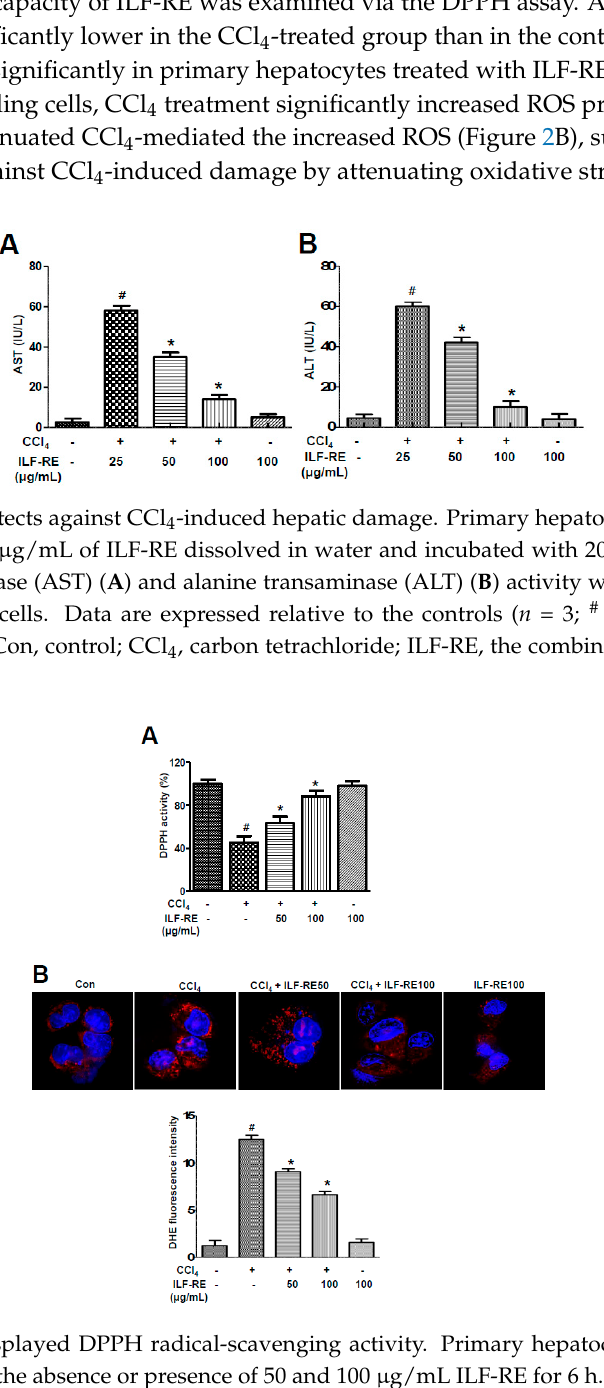
activity in the hepatocytes compared with only CCl 4 -treated hepatocytes (Figure 1A,B). Since herbal